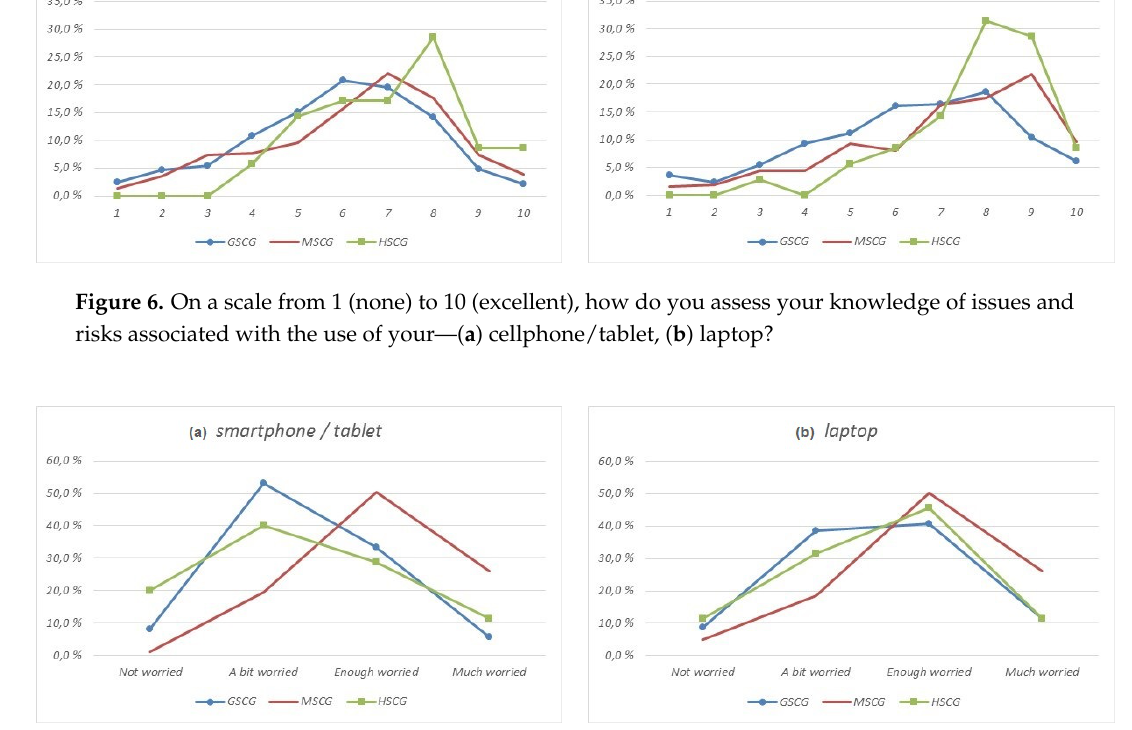
Figure 7. How concerned are you about the security of your—( a ) cellphone/tablet, ( b )